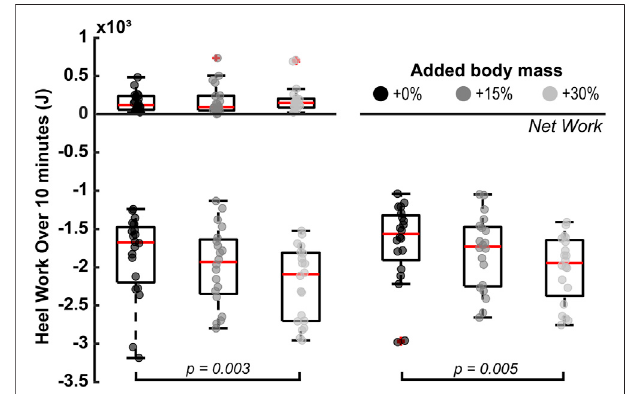
FIGURE 2 | Walking with an additional 30% of body mass signi fi cantly increased the magnitudes of the extrapolated to 10 min, negative ( p = 0.003) and net-negative ( p = 0.005) work during the heel strike phase. The horizontal square brackets indicate the adjusted signi fi cant pair-wise comparisons (N = 20). We added jitter to the data on the x-axis only for visualization purposes, using the scatter function in MATLAB